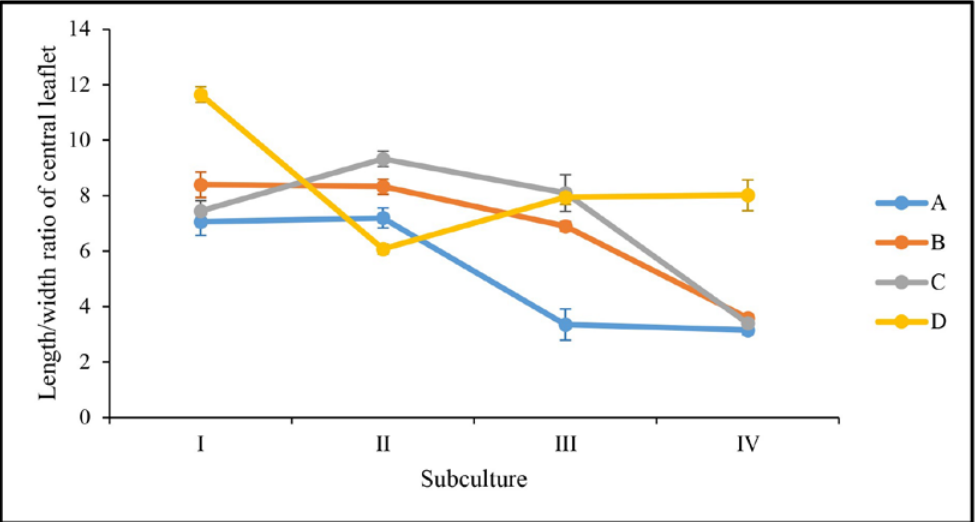
Figure 7. Effect of the number of subcultures (i.e., I, II, III, and IV) and the source of explants on length/width ratio of the central leaflet. The explants derived from the basal, near-basal, middle, and apical parts are respectively been illustrated as A, B, C, and D. Error bars represent standard error.